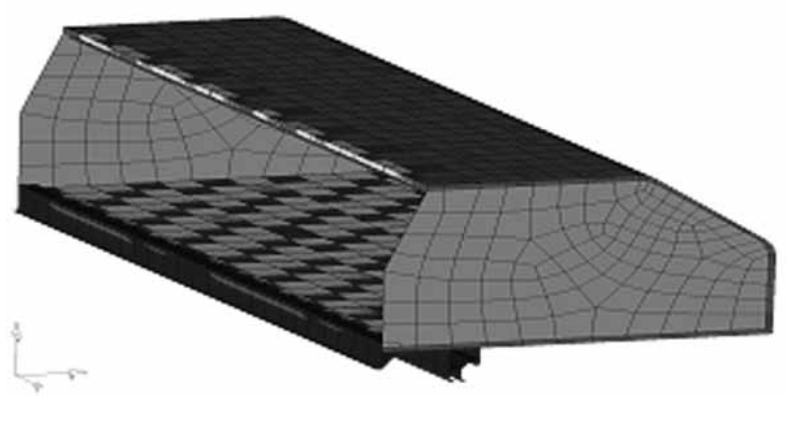
Fig. 9. Bin finite element model.